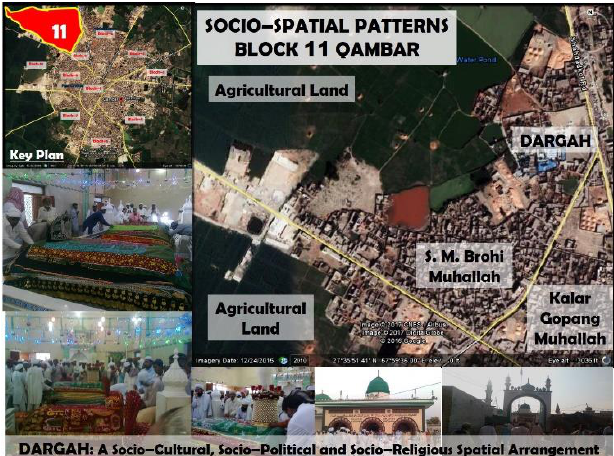
Fig. 14 . Analysis of urban design principles in Qambar: physical, social and economic dimensions of city in block 10